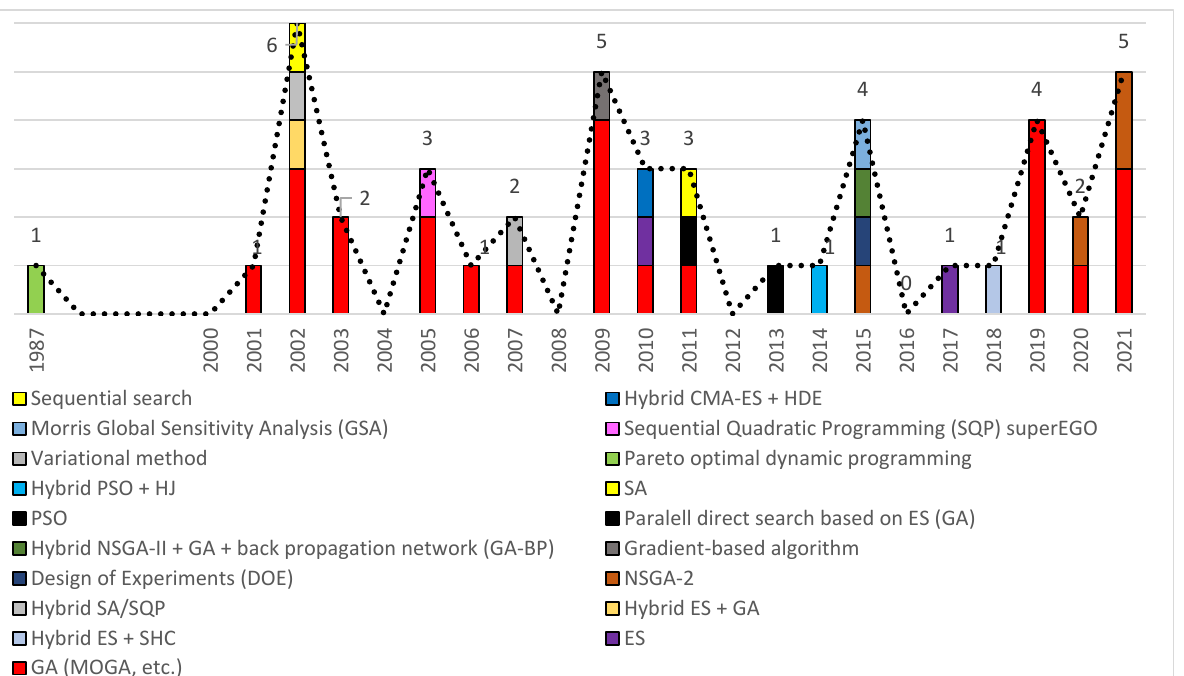
Figure 1. Number of applied optimization algorithms in BECEDO studies in chronological sequence.